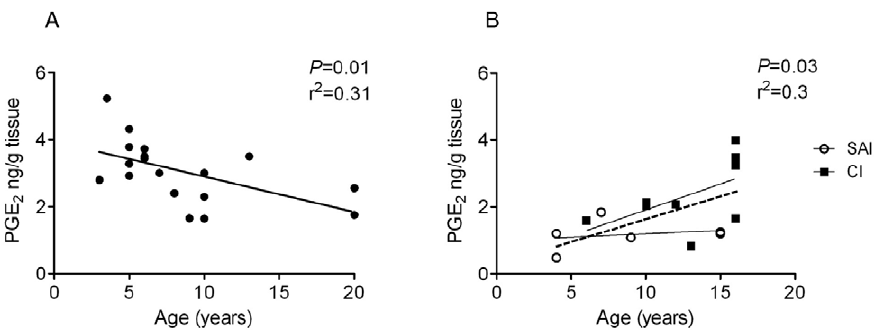
Figure 3. The relationship between horse age and PGE 2 levels in tendon extracts. (A) Normal flexor tendons (n=19) showed a significant negative correlation between PGE 2 levels and increasing age ( P =0.01, r 2 =0.31). (B) Injured tendons (n=15) comprised of both sub-acute and chronic injuries showed a significant positive correlation (dotted line) between PGE 2 levels and increasing age ( P =0.03, r 2 =0.3) although when separated for injury stage, neither sub-acute nor chronic injuries were significant in isolation (solid lines). SAI= sub-acute injury (3–6 weeks post injury, n=6), CI= chronic injury ( . 3 months post injury, n=9).